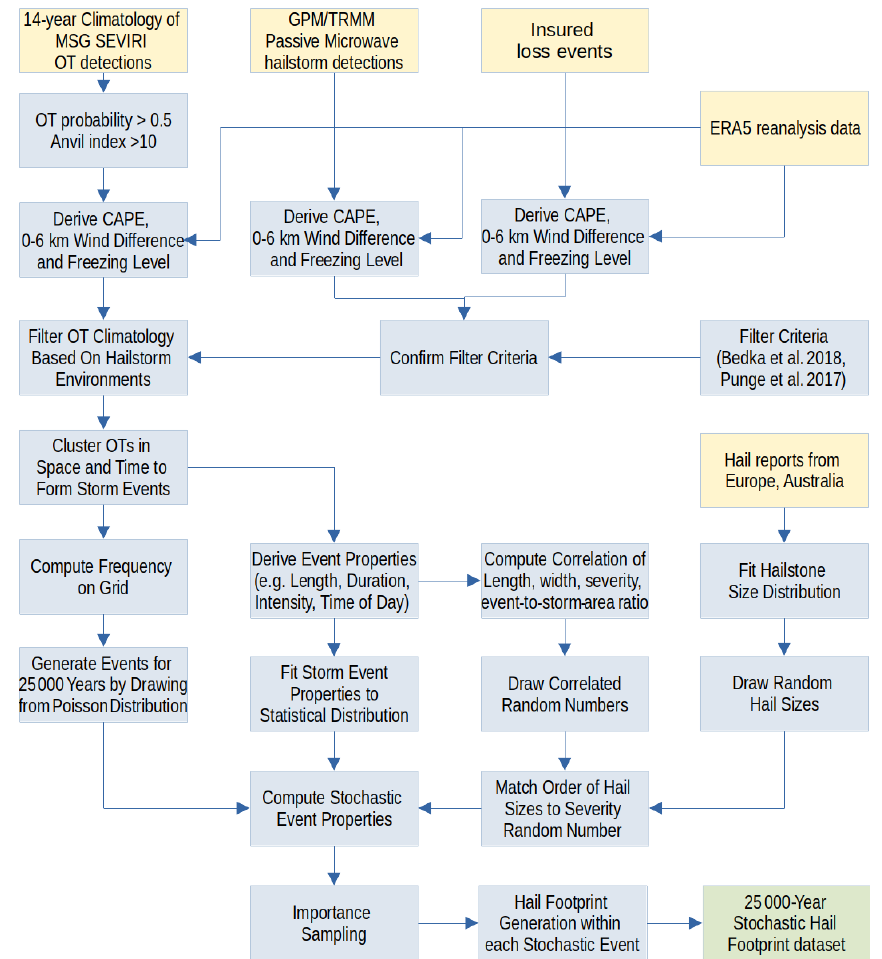
Figure 1. Diagram illustrating the functioning of the hail hazard model for South